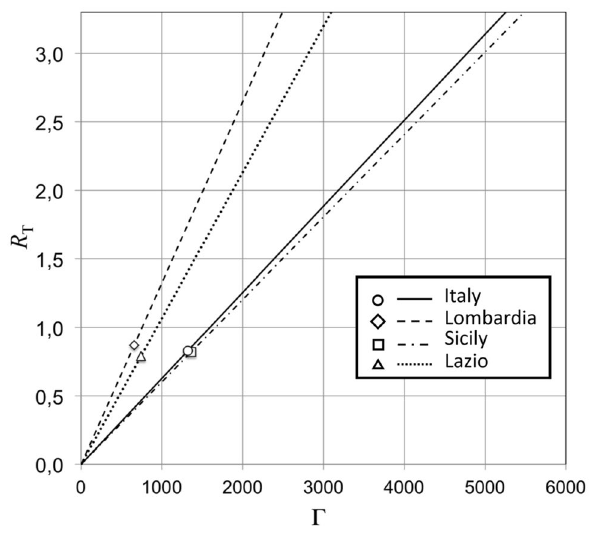
Figure 8. Reproduction number R T versus average number Γ of susceptible people that a single individual, positive for the virus, meets throughout her/his lifetime, for Italy (continuous line), Lombardia (dashed line), Sicily (dot-dashed line), and Lazio (dotted line). The present ( R T , Γ) values, as of January the 31th, 2021, are plotted as open circle, open lozenges, open square, and open triangle,